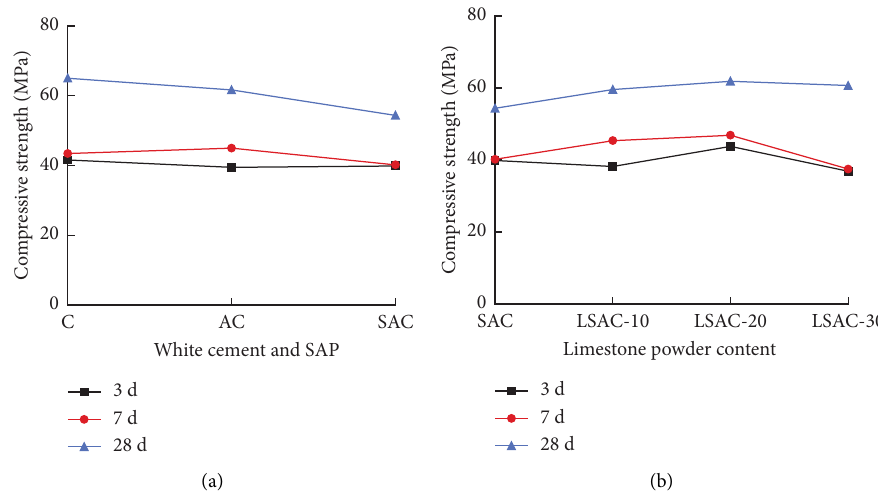
Figure 7: Compressive strength curves of diferent types of fair-faced concrete. (a) Efects of white cement and SAP. (b) Efect of limestone powder